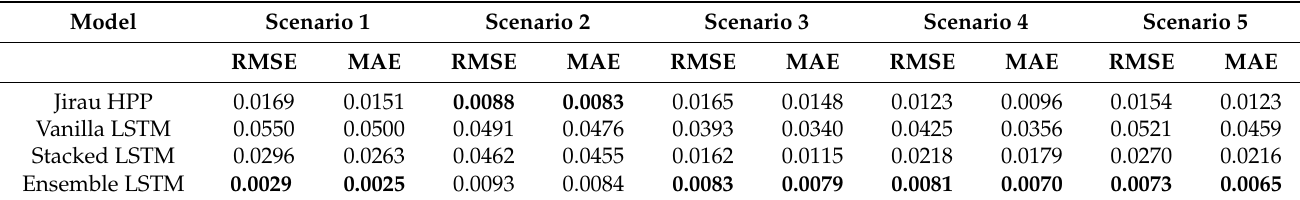
Table 2. Results of five different scenarios comparing the forecast erros of Jirau HPP, Vanilla LSTM, Stacked LSTM, and ensemble LSTM